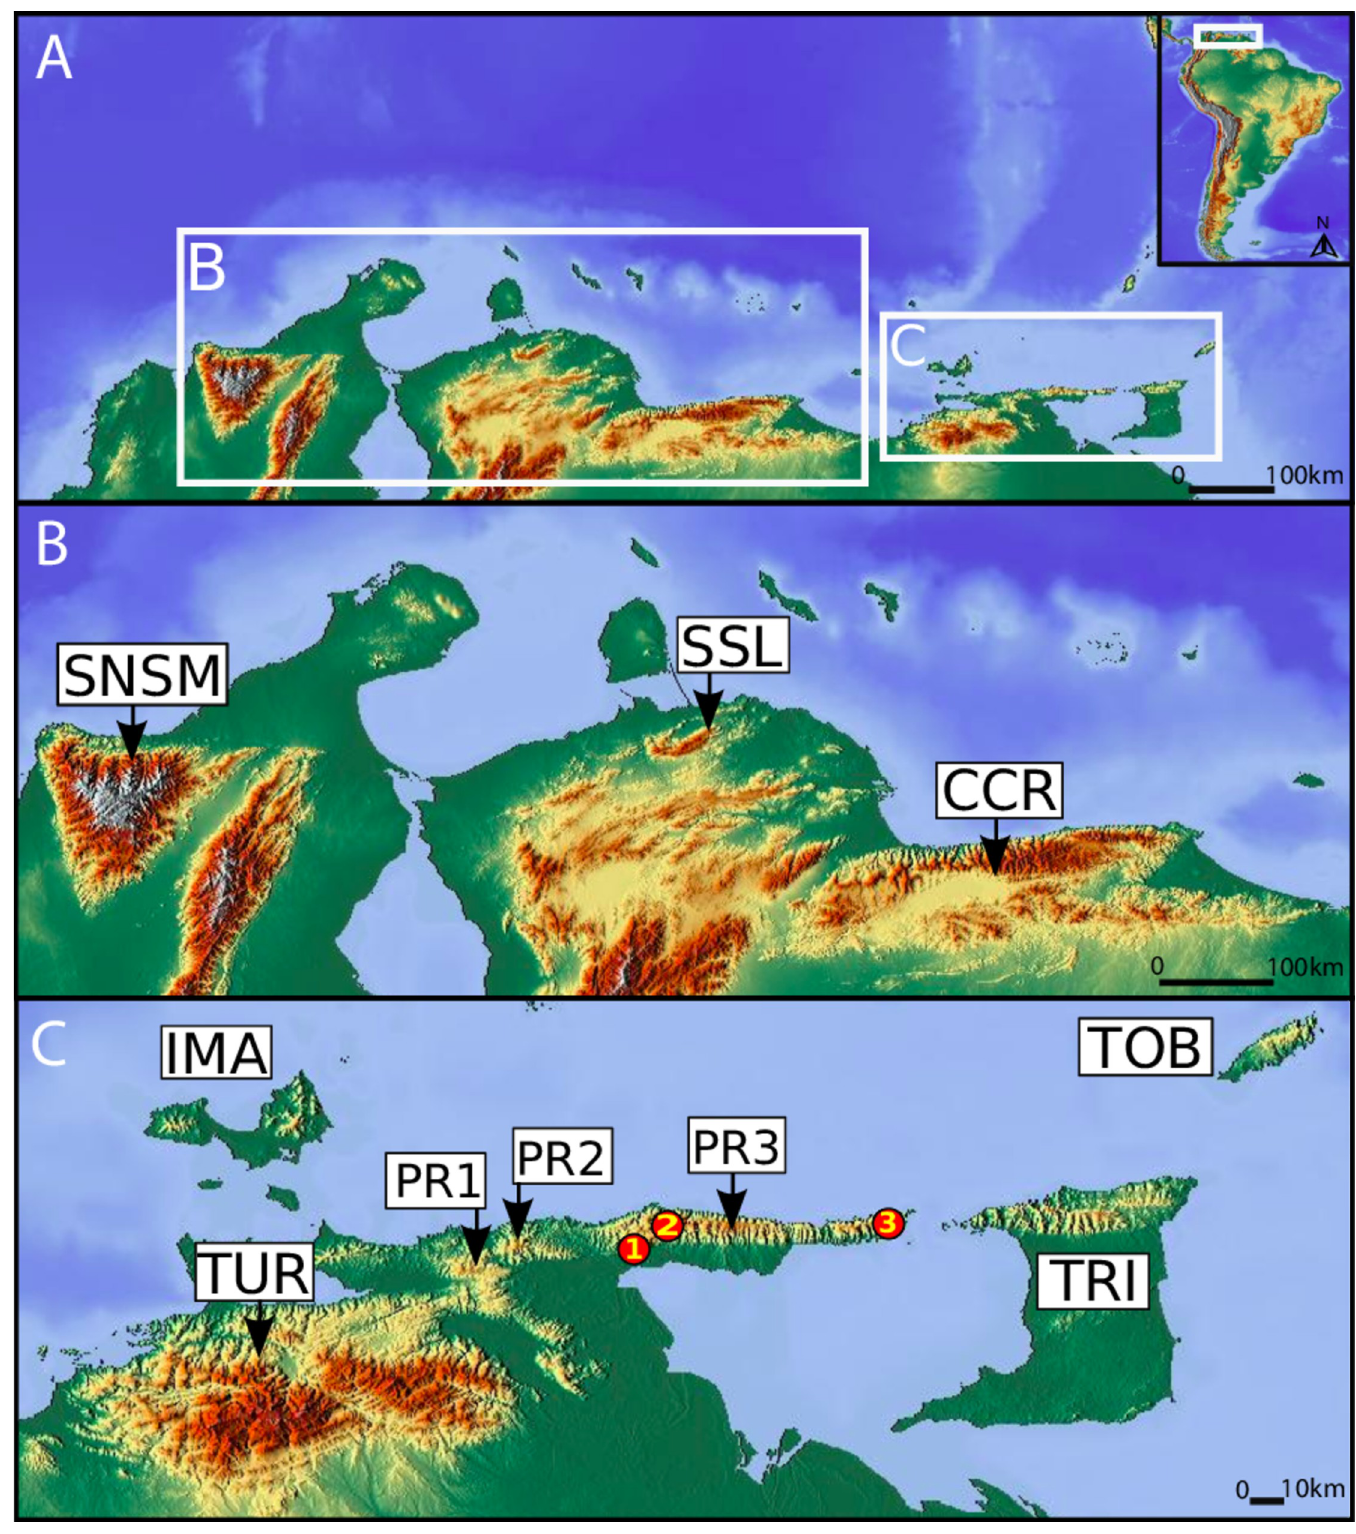
Fig 1. Map of northern South America showing from west to east: Sierra Nevada de Santa Marta (SNSM, Colombia), Sierra de San Luis (SSL), Cordillera de la Costa Central or Central Coastal Range (CCR), Turimiquire Massif (TUR), mountains of Isla de Margarita (IMA), and on the Eastern Coastal Range the